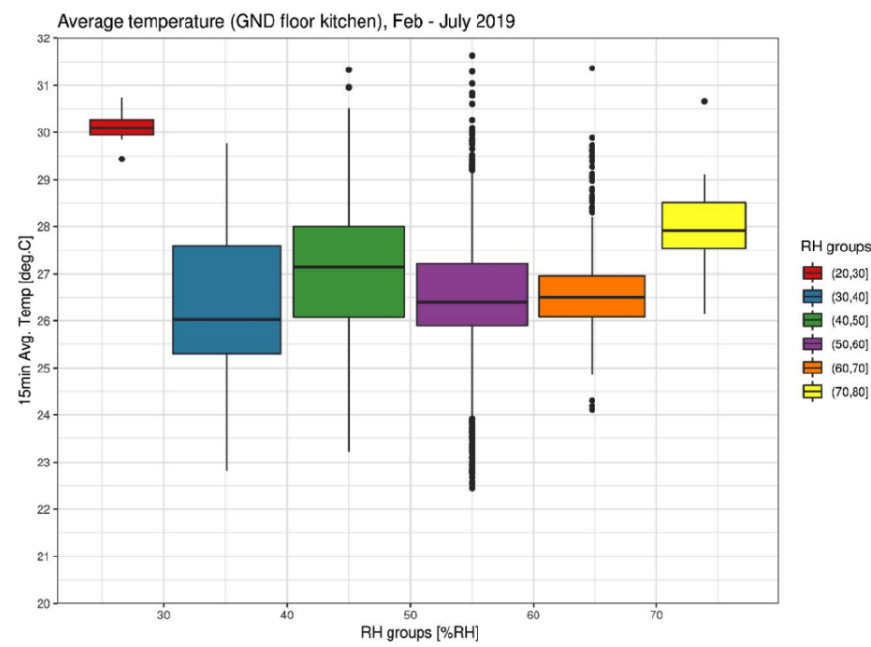
Figure 7. Temperature and RH boxplots for ground floor kitchen from February to July 2019.